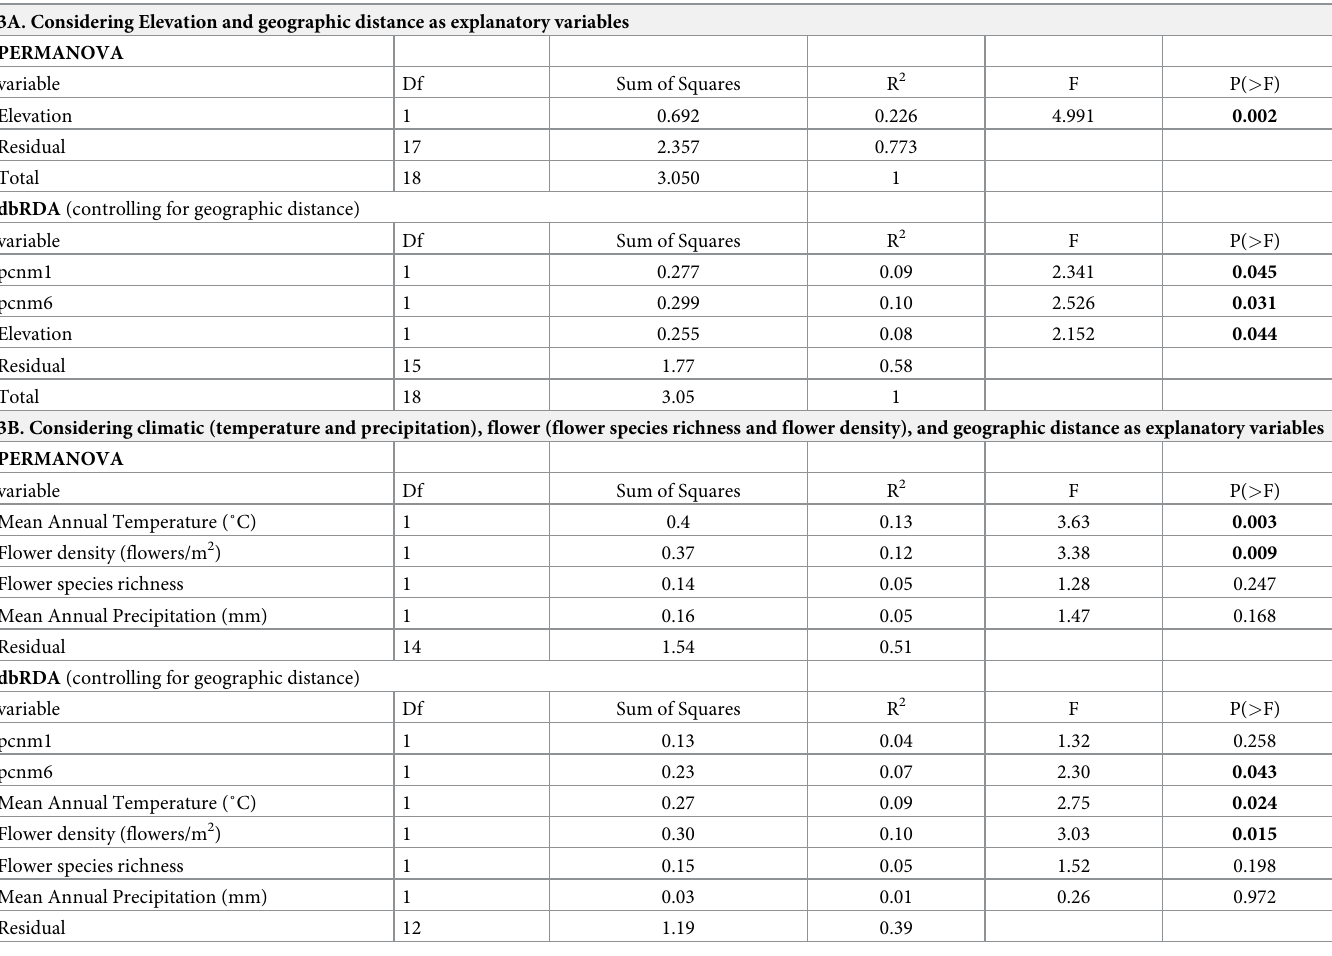
Table 3. Community composition vs elevation, geographical distance, climatic variables and flower